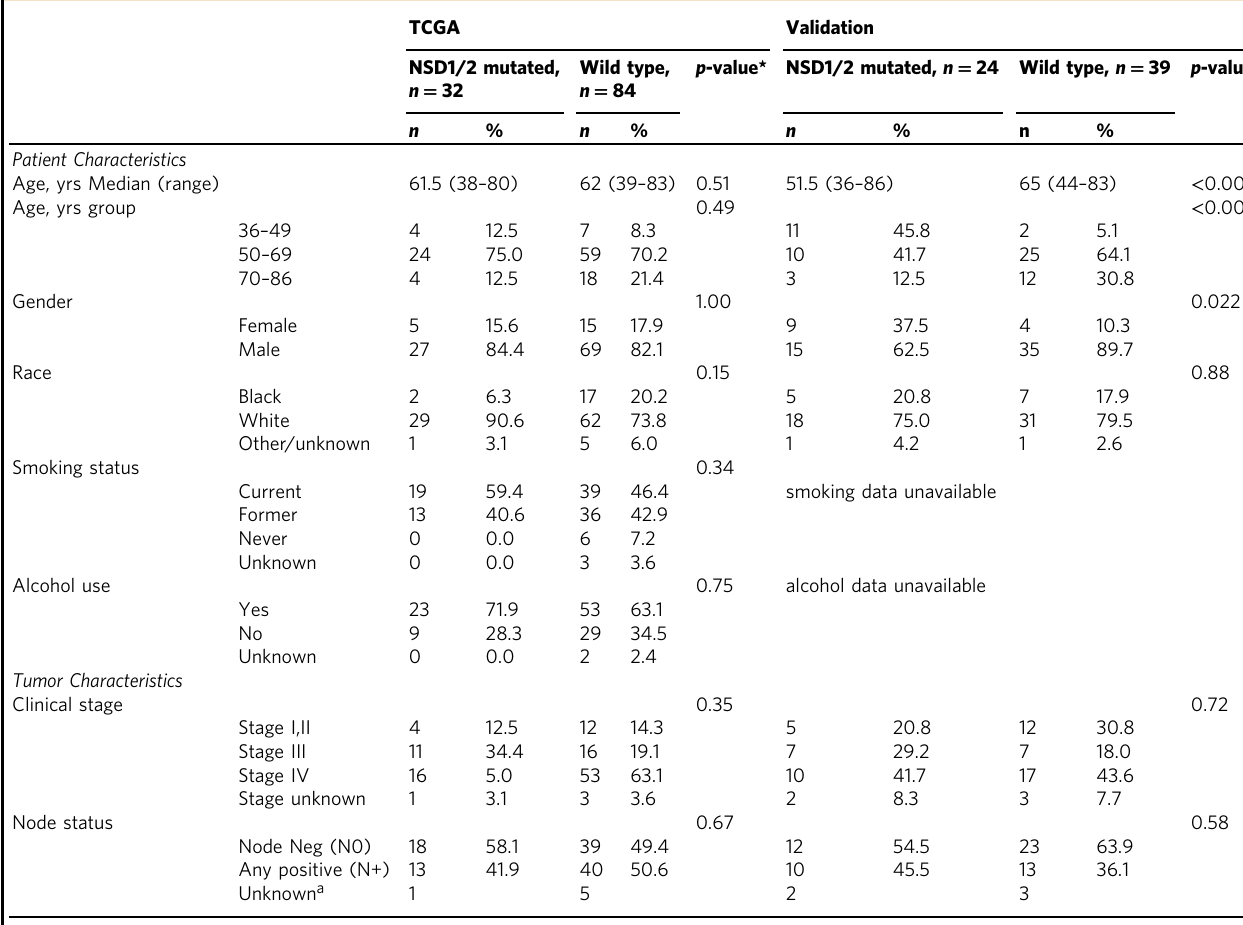
Table 1 Results from statistical analyses for association between clinical characteristics and NSD1 and NSD2 (NSD) mutation status for laryngeal samples in the discovery (TCGA) and validation